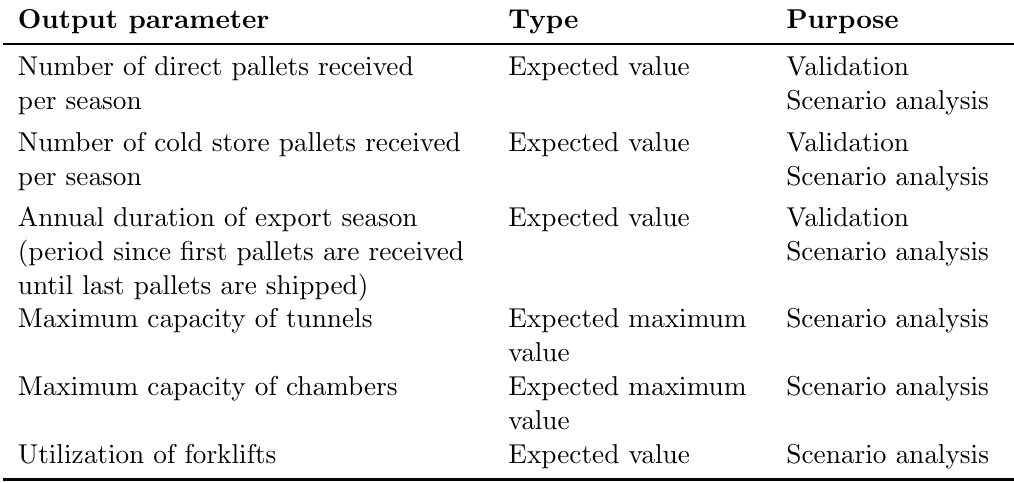
Table 1: Output parameters estimated in the simulation